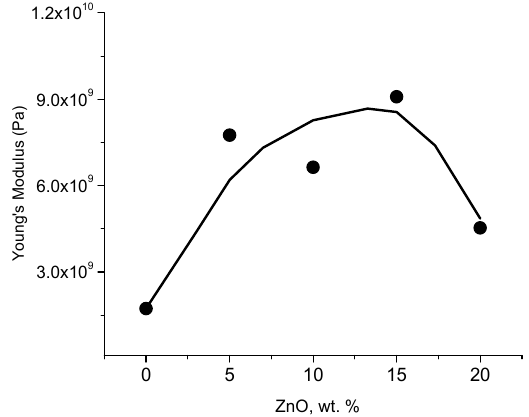
Figure 5. Dependence of Young’s modulus of CS ZnO NPs films with different wt.% of NPs (points). The continuous line is a guide to the eye.